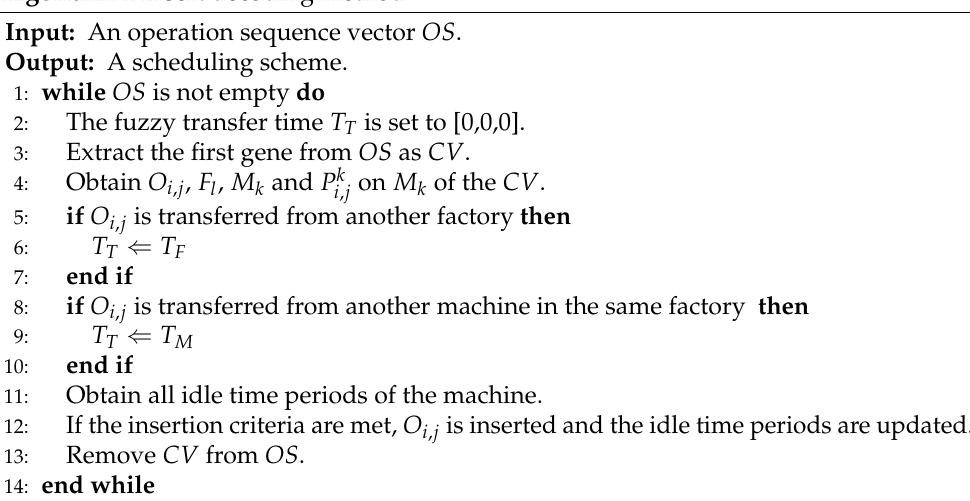
Algorithm 2 Insert decoding method